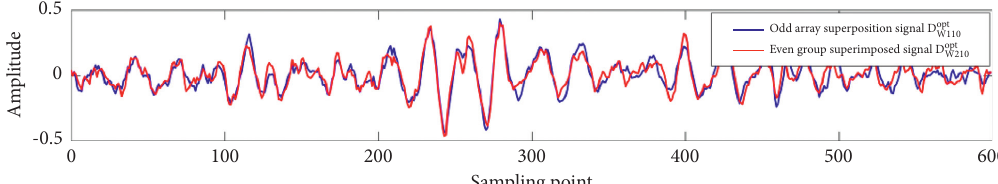
Figure 12: The superimposed signals of the odd group and even group after superimposing 10 times with the improved